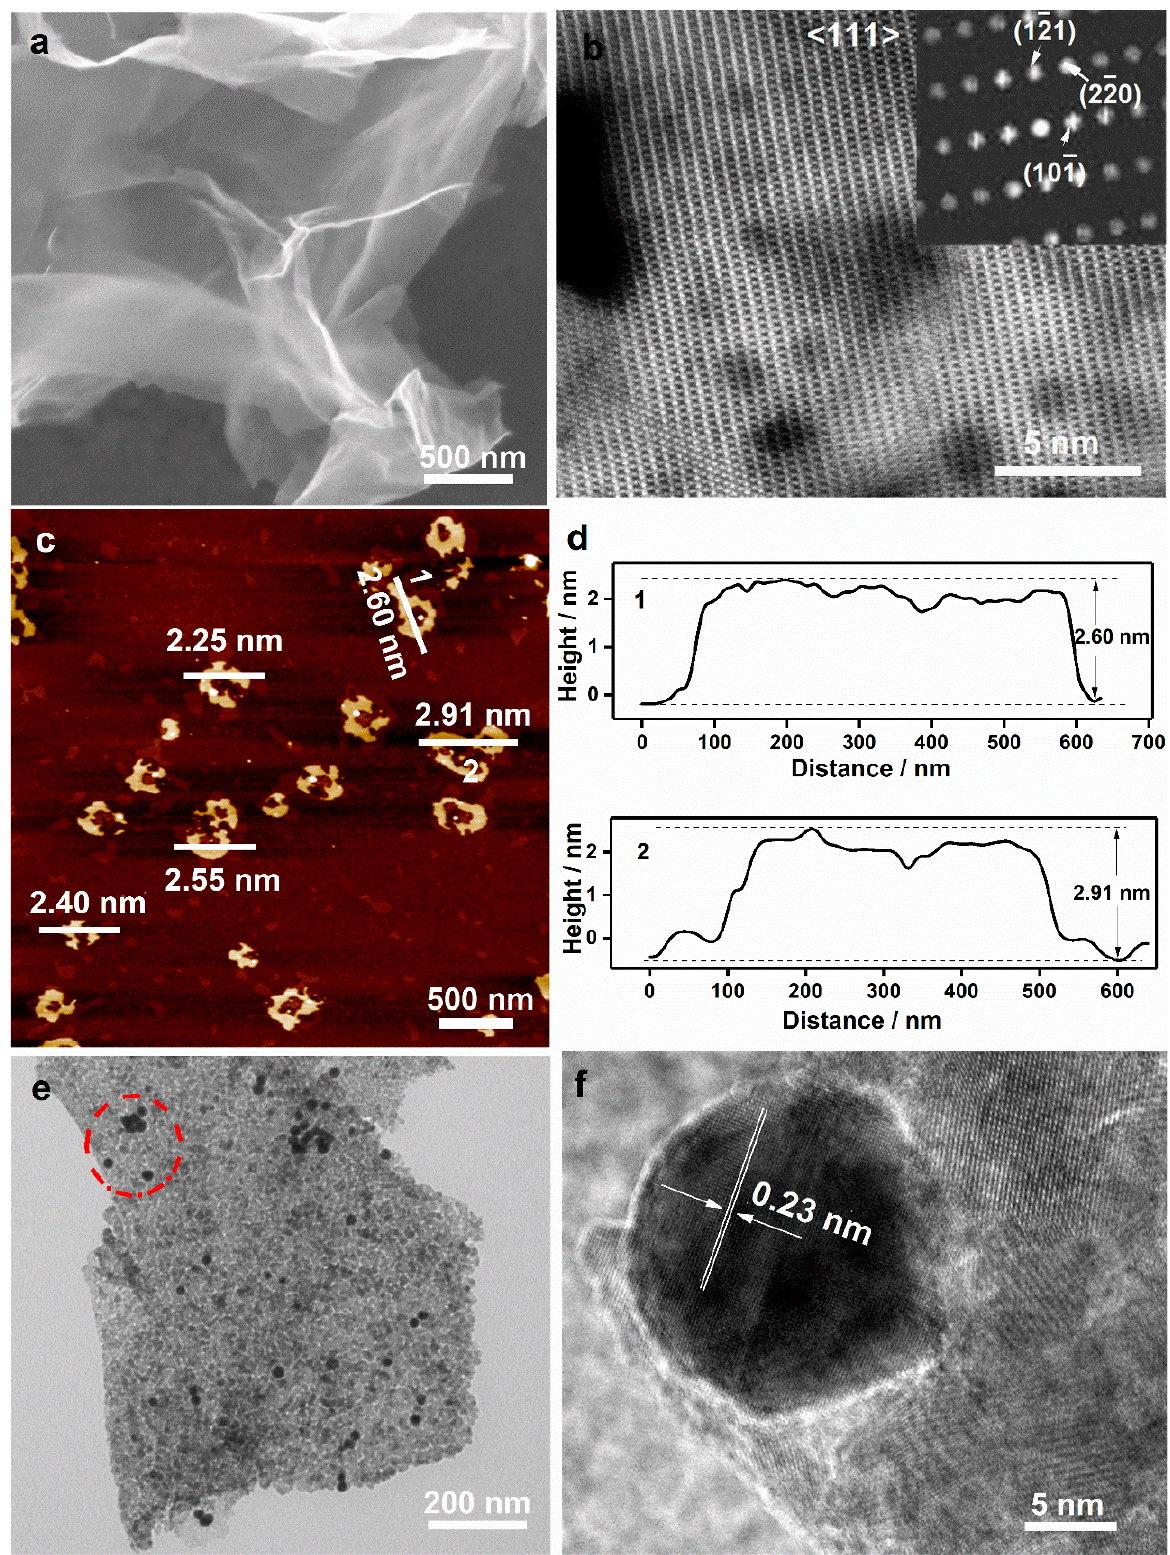
Figure 2. ( a ) SEM and ( b ) STEM-HAADF images of Co 3 O 4 ultrathin nanosheets; ( c ) AFM image and ( d ) the corresponding height profiles of Co 3 O 4 ultrathin nanosheets; and ( e ) TEM and ( f ) HRTEM images of Co 3 O 4 /Au nanocomposites.